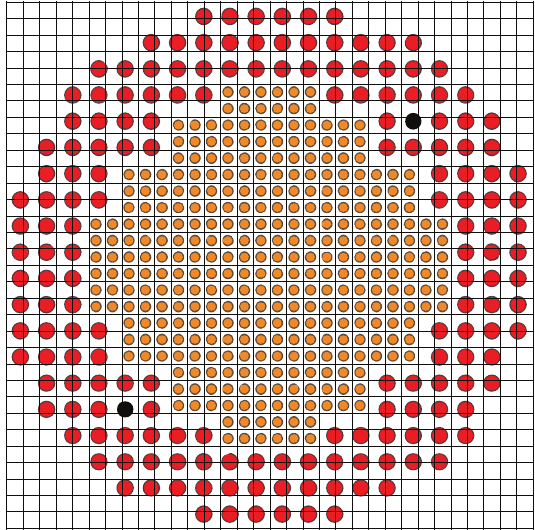
Figure 7: UO 2 fuel cell-size meshing.